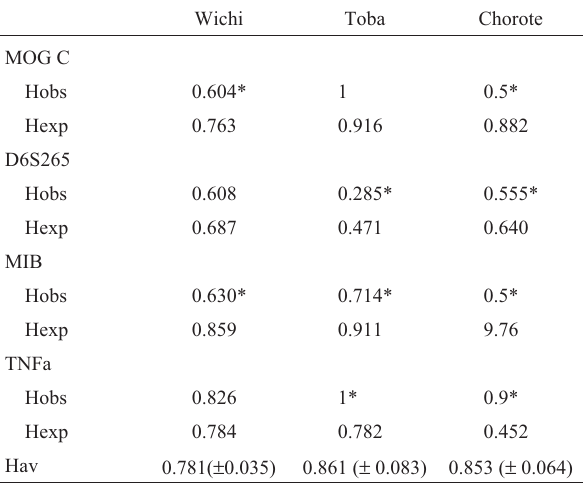
Table 4 - Genetic differentiation analysis by paired populations. Locus Pairs of populations Prob